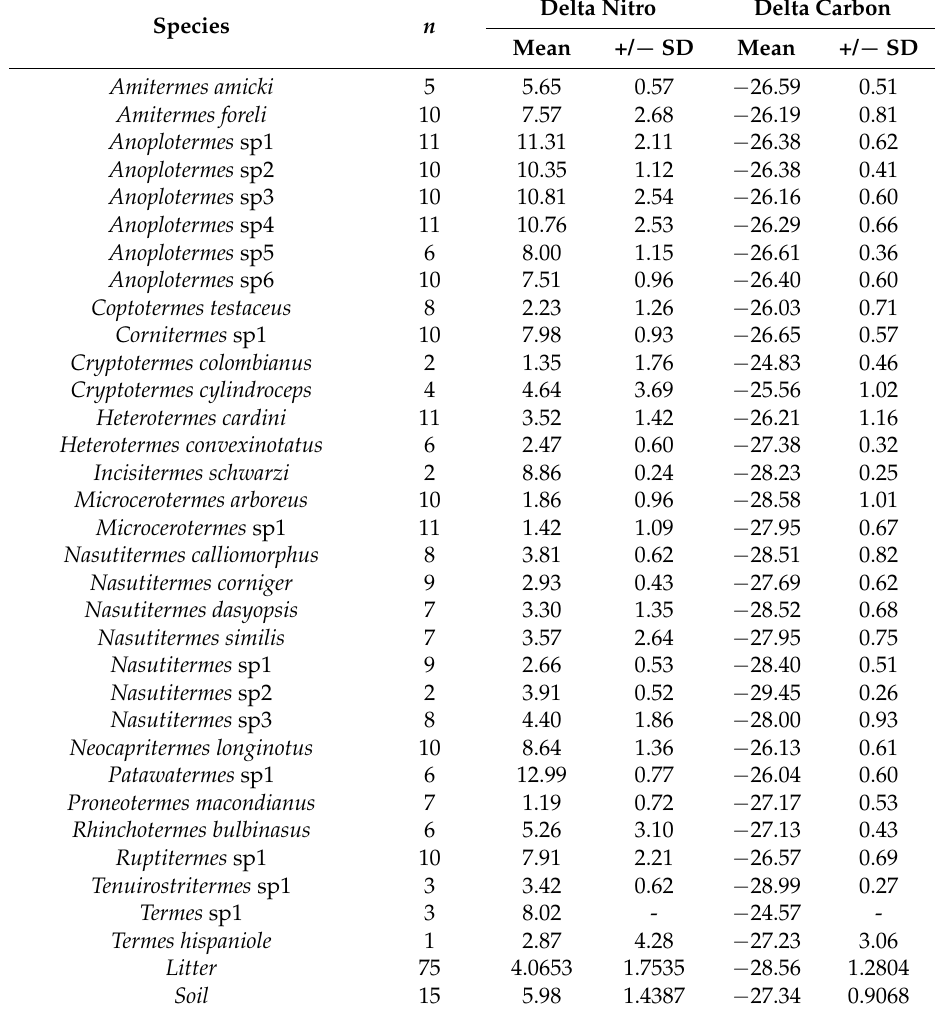
Table A4. Isotopic composition of δ 13